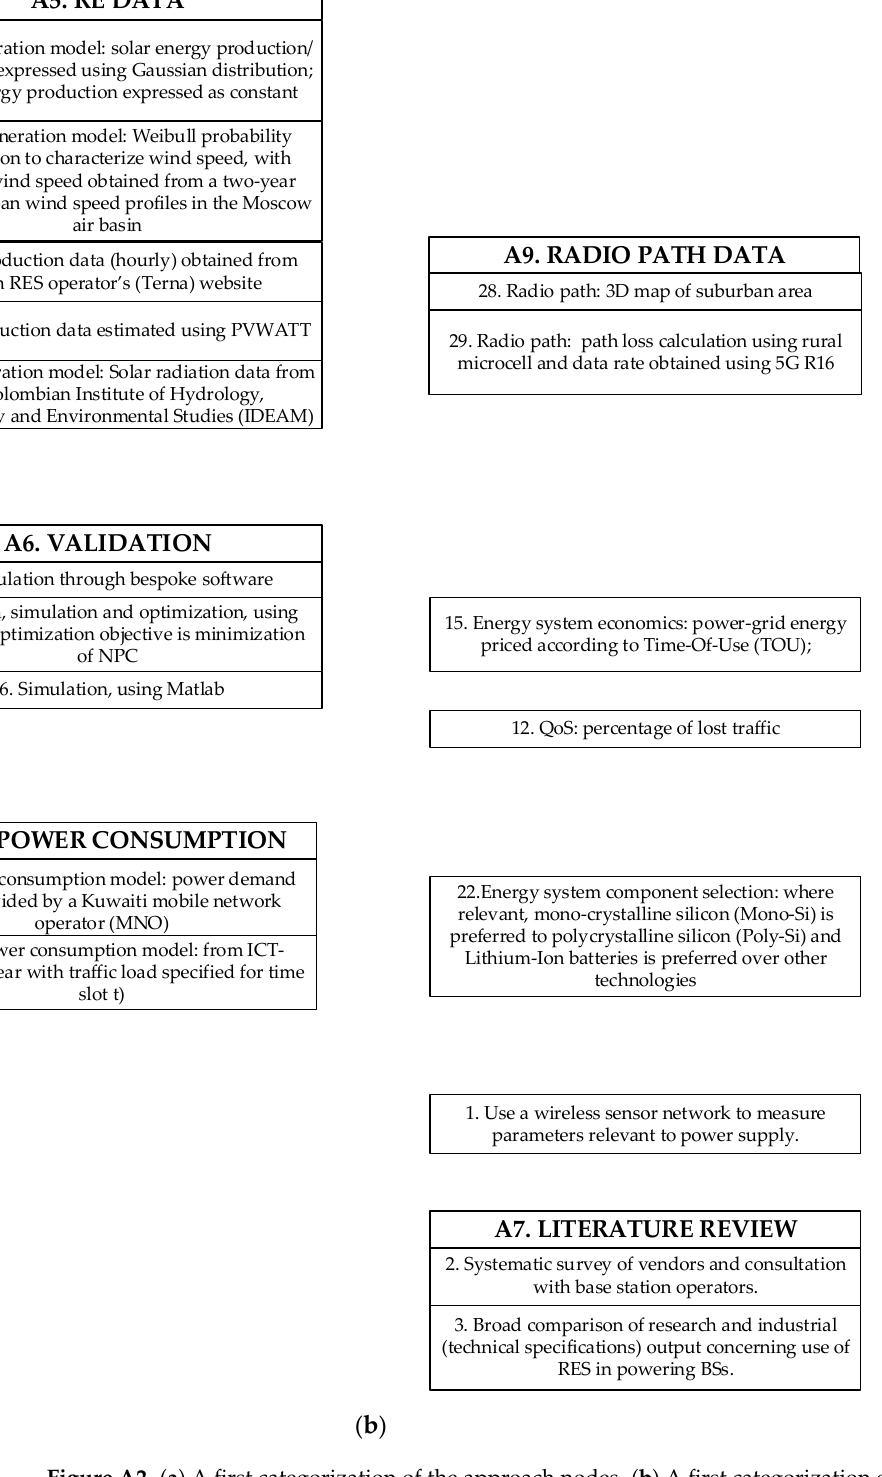
Figure A2. ( a ) A first categorization of the approach nodes. ( b ) A first categorization of the ap-